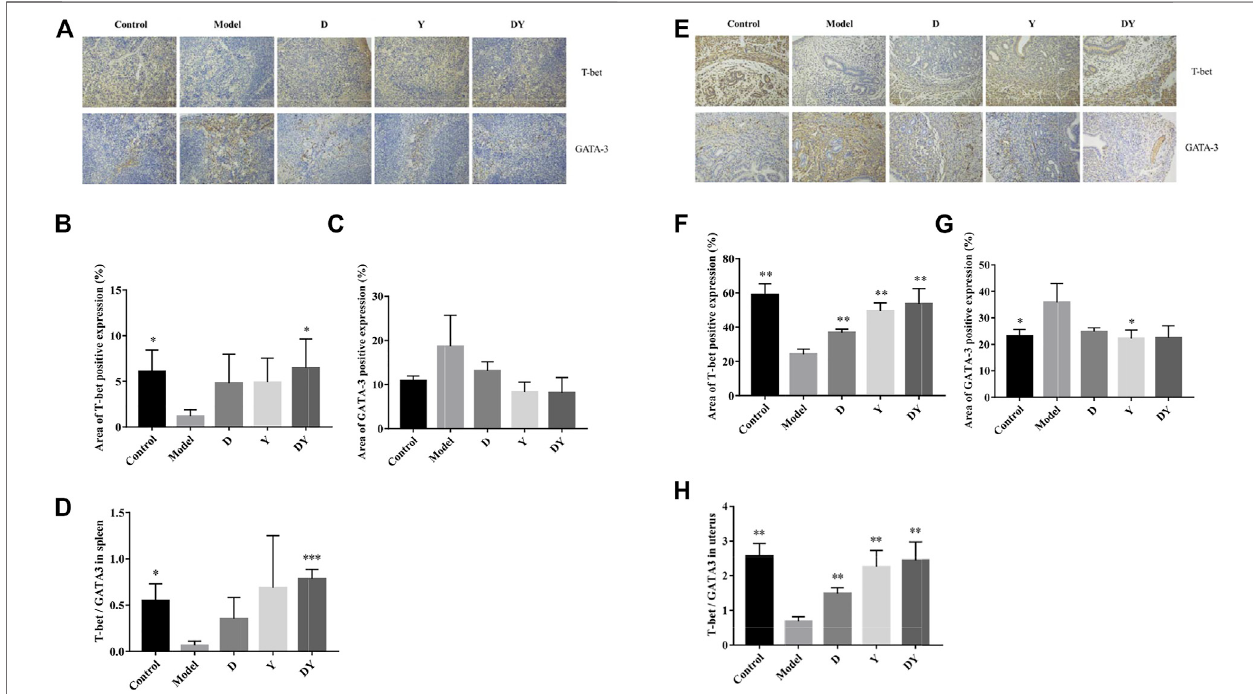
FIGURE 2 | Immunohistochemical analysis of T-bet ( × 200) and GATA-3 ( × 200) expression in spleen and uterus. Staining results of spleen tissue sections (A) . The positive area of T-bet (B) and GATA-3 (C) in the spleen. Evaluation of T-bet/GATA-3 in the spleen (D) . Staining results of uterus tissue sections (E) . The positive area of T-bet (F) andGATA-3 (G) intheuterus.EvaluationofT-bet/GATA-3 intheuterus (H) .(*** p < 0.001,** p < 0.01,and* p < 0.05,vs.Modelgroup).EffectofD,Y,andDYon Th1/Th2 Related Cytokines and Transcription Factor mRNA Expression in Spleen and Uterus Tissues.